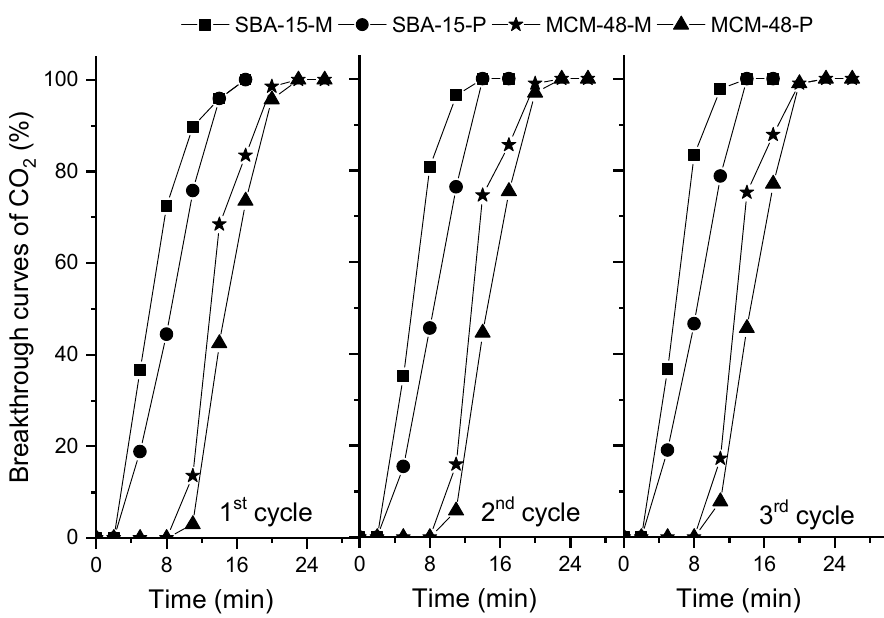
Figure 4. CO 2 breakthrough curves of the prepared materials in dynamic conditions. The highest CO 2 adsorption capacity in dynamic conditions was detected for the MCM-48-P sample modified with 1-methylpiperazine (4.4 mmol/g). The CO 2 adsorption capacities of the samples decrease in the following order: MCM-48-P > SBA-15-P > MCM-48-M > SBA-15M. The results show that structural characteristics of the mesoporous supports as well as the nature and the content of the functional groups significantly influence the formation and localization of the adsorption sites. The modification with 1-methylpiperazine and morpholine resulted in higher content of the finely dispersed adsorption sites in comparison to the parent mesoporous silica. The modification by 1-methylpiperazine leads to higher CO 2 adsorption capacity on MCM-48-P(P) and SBA-15-P(P) than that of the morpholine-modified MCM-48-M and SBA-15-M materials (Table 2). We anticipate that structural characteristics of MCM-48-P combined with the bis amine moiety of the 1-methylpiperazine leading to the formation of bis bicarbonates are responsible for the outstanding CO 2 uptake of 4.4 mmol/g (Scheme 2). The positive effect over the CO 2 adsorption of the modification with 1-methylpiperazine compared to morhpoline can be observed also for SBA-15 (Table 2 entry 3 vs. entry 5). The much higher selectivity to CO 2 over N 2 was calculated for the modified samples in comparison to the initial ones based on the IAST theory (Table 2).